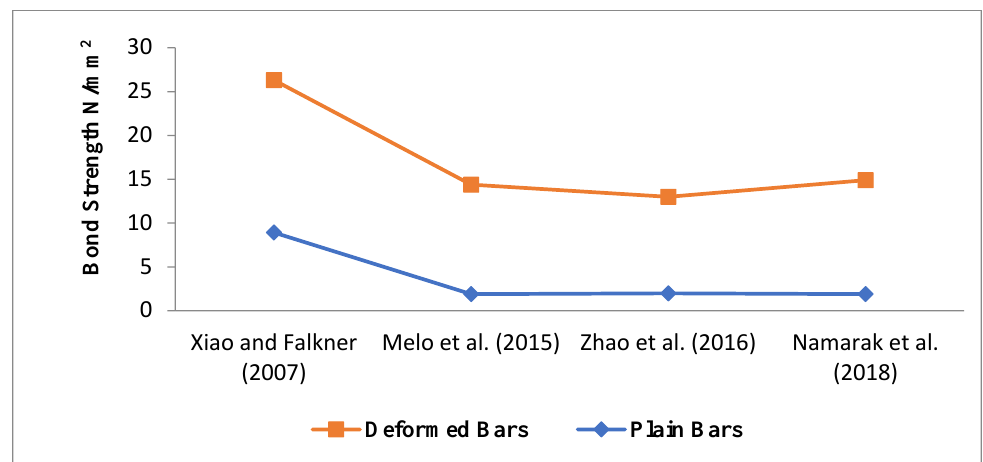
Figure 7. Bond strength of concrete with plain and deformed steel bars [10,68,69,94].